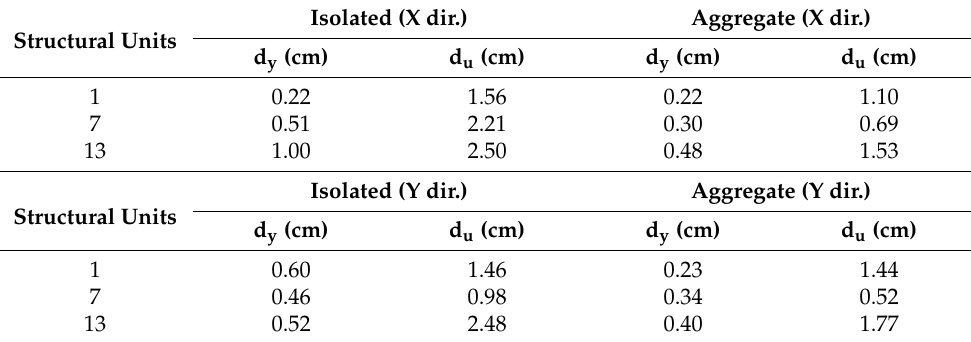
Table 4. Target displacements, d y and d u , for the examined SUs. Structural Units